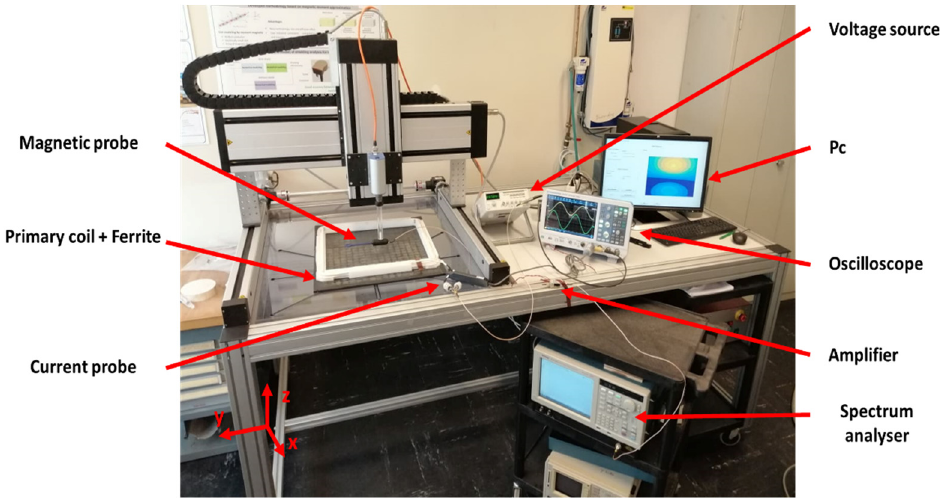
Figure 18. Near-field test bench.